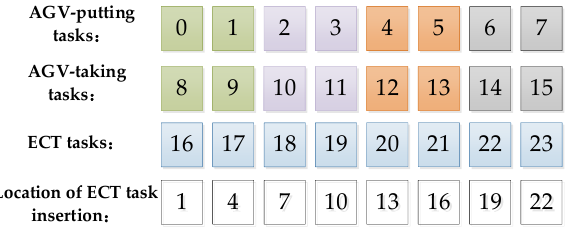
Figure 4. ACGA flow.